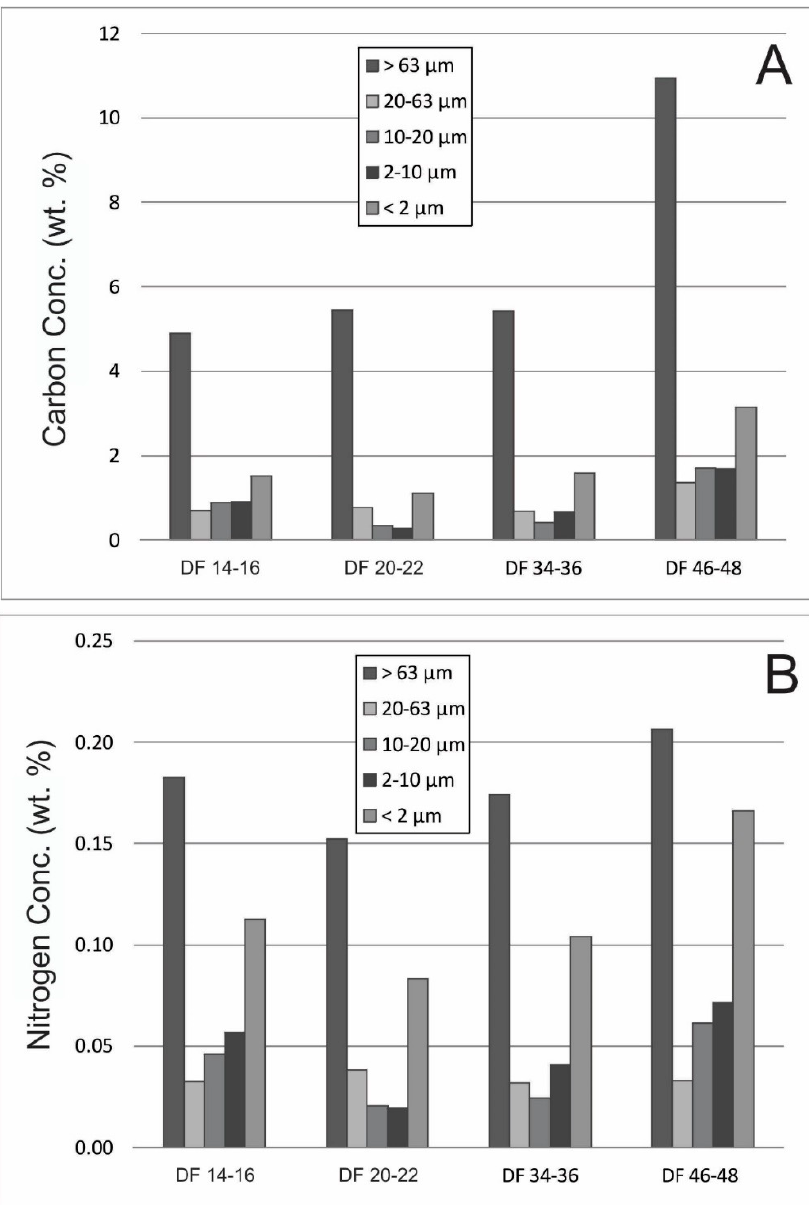
Figure 10. Distribution of Organic Carbon ( A ) and Total Nitrogen ( B ) for four selected samples, size fractionated into five fractions: <2µm, 2–10µm, 10–20µm, 20–63 µm and >63µm.